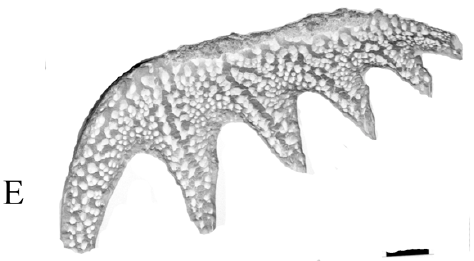
Figure 1. Changes in the tooth plates as lungfish develop. ( A ) Prearticular tooth plates from a juvenile Neoceratodus forsteri , AN 58-1999, raised in the laboratory from an egg collected in the Brisbane River in 1992. ( B ) Prearticular tooth plates from an adult N . forsteri , QM 26014, collected in the Brisbane River in 1974. ( C ) Upper tooth plate from a juvenile Mioceratodus diaphorus , QMF 44425, from the Carl Creek Limestones in Riversleigh, Miocene. ( D ) Upper tooth plate of a specimen of M . diaphorus , QM 11023, from Frome Downs, South Australia, Oligocene. Changes in the permanent dentition are dramatic in specimens of the family Neoceratodontidae as the fish develop, but this does not mean that they come from separate species. ( E ) A scanning electron micrograph of the pulp cavity surface of a prearticular tooth plate of Mioceratodus anemosyrus , QMF 51703, from Riversleigh, showing cores of petrodentine running along each ridge, flanked by interdenteonal dentine. Scale bars = 1 cm.